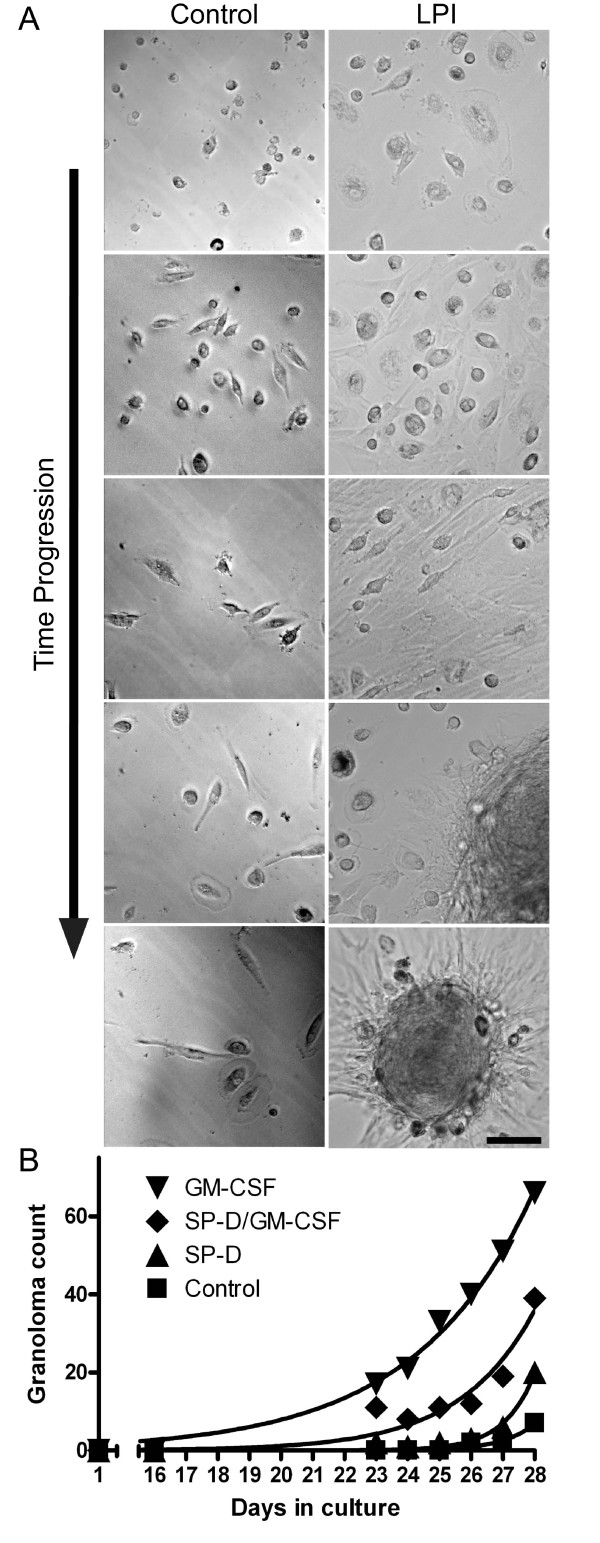
LPI cells, but not the control cells, isolated from BALF spontaneously form granuloma. (A) While cells from the control BALF did not elongate to a greater degree, many LPI cells became highly elongated. LPI cells then formed granulomas while the control cells remained relatively unchanged (26 days ex vivo). All of these cells moved to one location and eventually formed granulomas over time. The formation of these granulomas was reproducible under different culturing conditions. Images represent randomly selected cells captured every 3-4 days. Bar, 100 μm. (B) Effect of SP-D and GM-CSF on granuloma formation. Treatment of cells with GM-CSF greatly enhanced the formation of granulomatous structures whereas SP-D reduced the effect of GM-CSF-mediated granuloma formation. Non-linear regression analysis and comparison by F-test revealed statistical differences in granuloma formation over the entire experimental period among these four different treatments (p < 0.05).